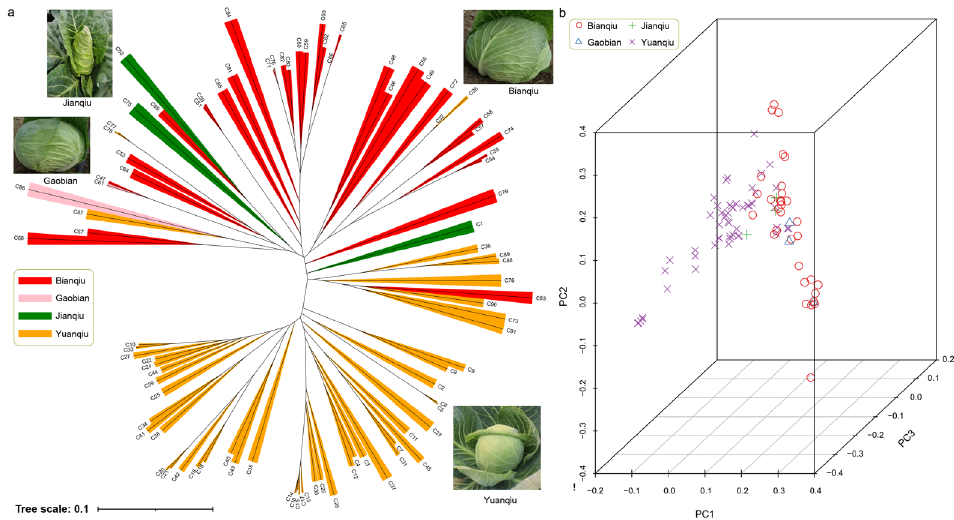
Figure 1. Phylogenetic tree and principal component analysis (PCA) of 91 B. oleracea accessions using SNPs. ( a ) A neighbor joining phylogenetic tree of 91 B. oleracea accessions. The B. oleracea leaf ball shape features are displayed on the evolutionary tree using four different colors. ( b ) Principal component analysis (PCA) of chayote accessions using the SNPs of 91 B. oleracea accessions.